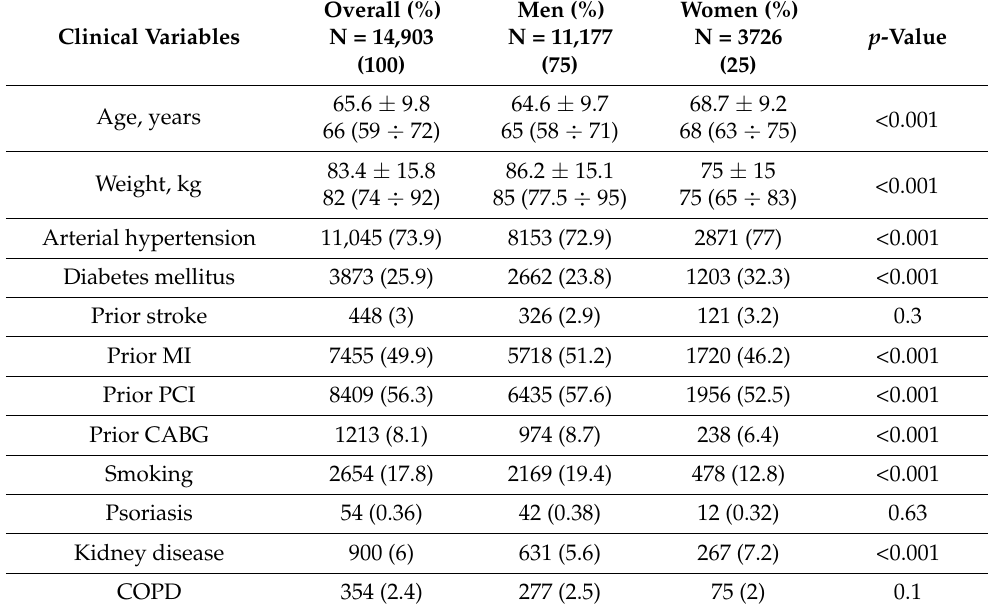
Table 1. Patient characteristics.